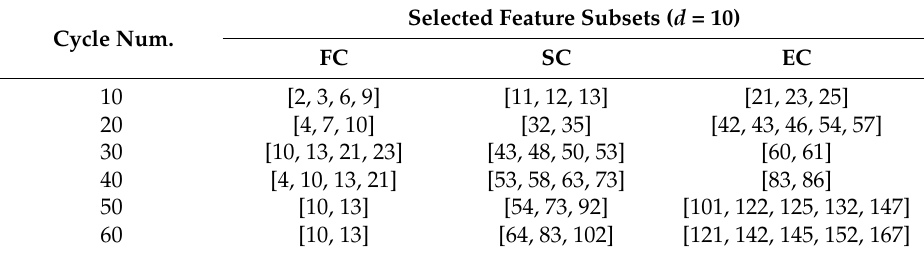
Table 1. Selected feature subsets.